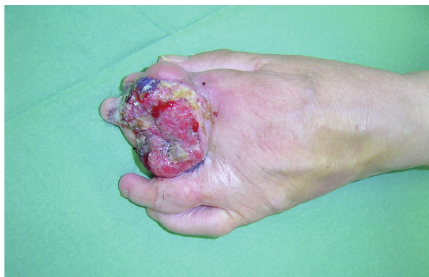
Figure 1: Preoperative status: 4 × 5 cm measuring, exulcerating and partly necrotic tumor.